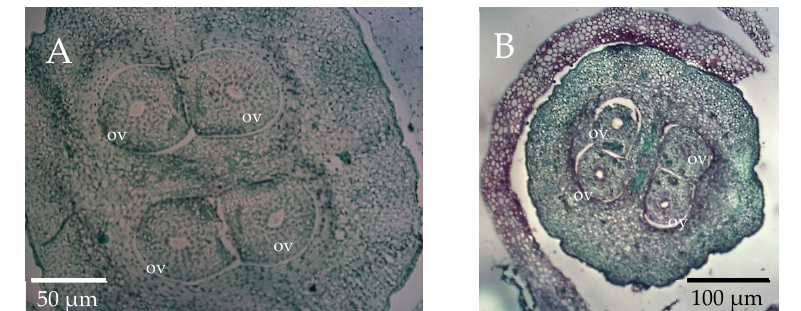
Figure 3. Transverse sections of olive ovary containing four ovules (ov). ( A ) Four fully developed ovules with round open embryo sacs (4/4). ( B ) Three fully developed ovules and one undeveloped ovule, without embryo sac (3/4).